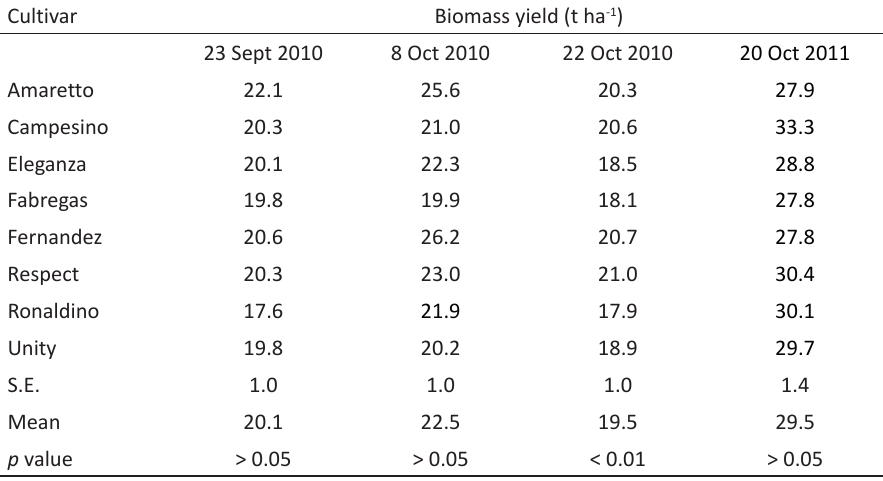
Table 2. Biomass yield of eight maize cultivars harvested on 3 dates in 2010 and one in 2011 in Southern Finland. Data shown are means of 4 replicates. Cultivar